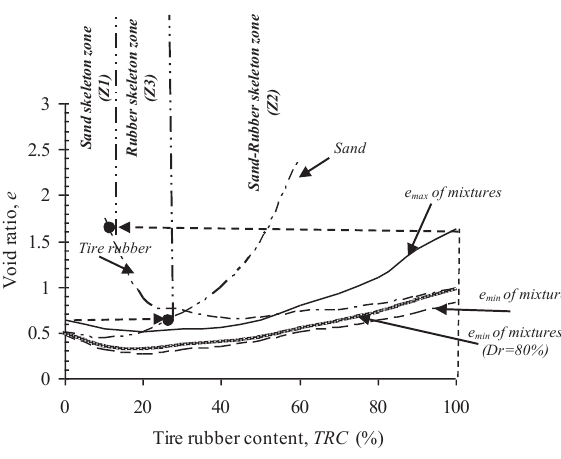
Fig. 4. The variation in the maximum and minimum void ratio of sand-rubber mixtures, void ratio of mixtures ( Dr = 80%), void ratio of the sand and the rubber in the mixtures ( Dr = 80%) Regarding the effect of tire rubber on the induced lateral deformation, it was found that tire rubber material TRM has significant effects on such lateral strains, ε 2&3 . For clean sand, the minor strain ε 3 increased steadily with increasing the applied load and reached 5.2% at the maximum stress ratio η max and 14.5% at failure. Minor principal strain ε 3 , however, decreased clearly when tire rubber material TRM was added to sand. For example, at the maximum stress ratio η max = 1.61, ε 3 decreased to 5.0, 4.8, 3.6, 2.2 and 2.1% as the rubber content increased to 10, 20, 30, 40 and 50% respectively, compared with 5.2% for clean sand. When the specimen failed, the accumulated ε 3 was only 3.7% for sand containing 50% rubber compared with 14.5% for clean sand. Adding tire rubber material showed similar effect on the intermediate principal strain ε 2 . For example, sand with 10, 20, 30, 40 and 50% rubber exhibited ε 2 of only 6.6, 5.1, 4.5, 2.9 and 2.3% respectively compared with 8.0% for clean sand. Results of both intermediate and minor principal strains indicated that TRM effectively restrained lateral deformation. Therefore, such mixtures can be used effectively as backfill behind retaining walls to decrease the induced lateral pressure.